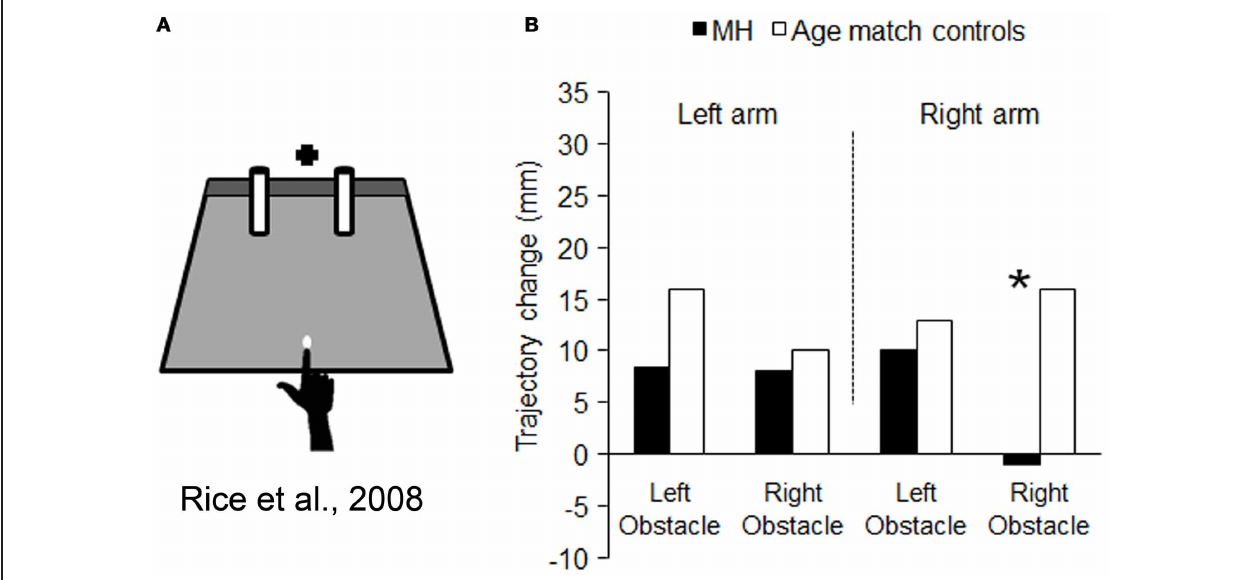
summarizes the mean amount of change in trajectory resulting from changing the location of either obstacle: in striking contrast to controls, when M.H. reached using with his right arm his trajectories were completely unaffected by the location of the obstacle within the right half-field. Asterisks highlight significance differences between M.H. and